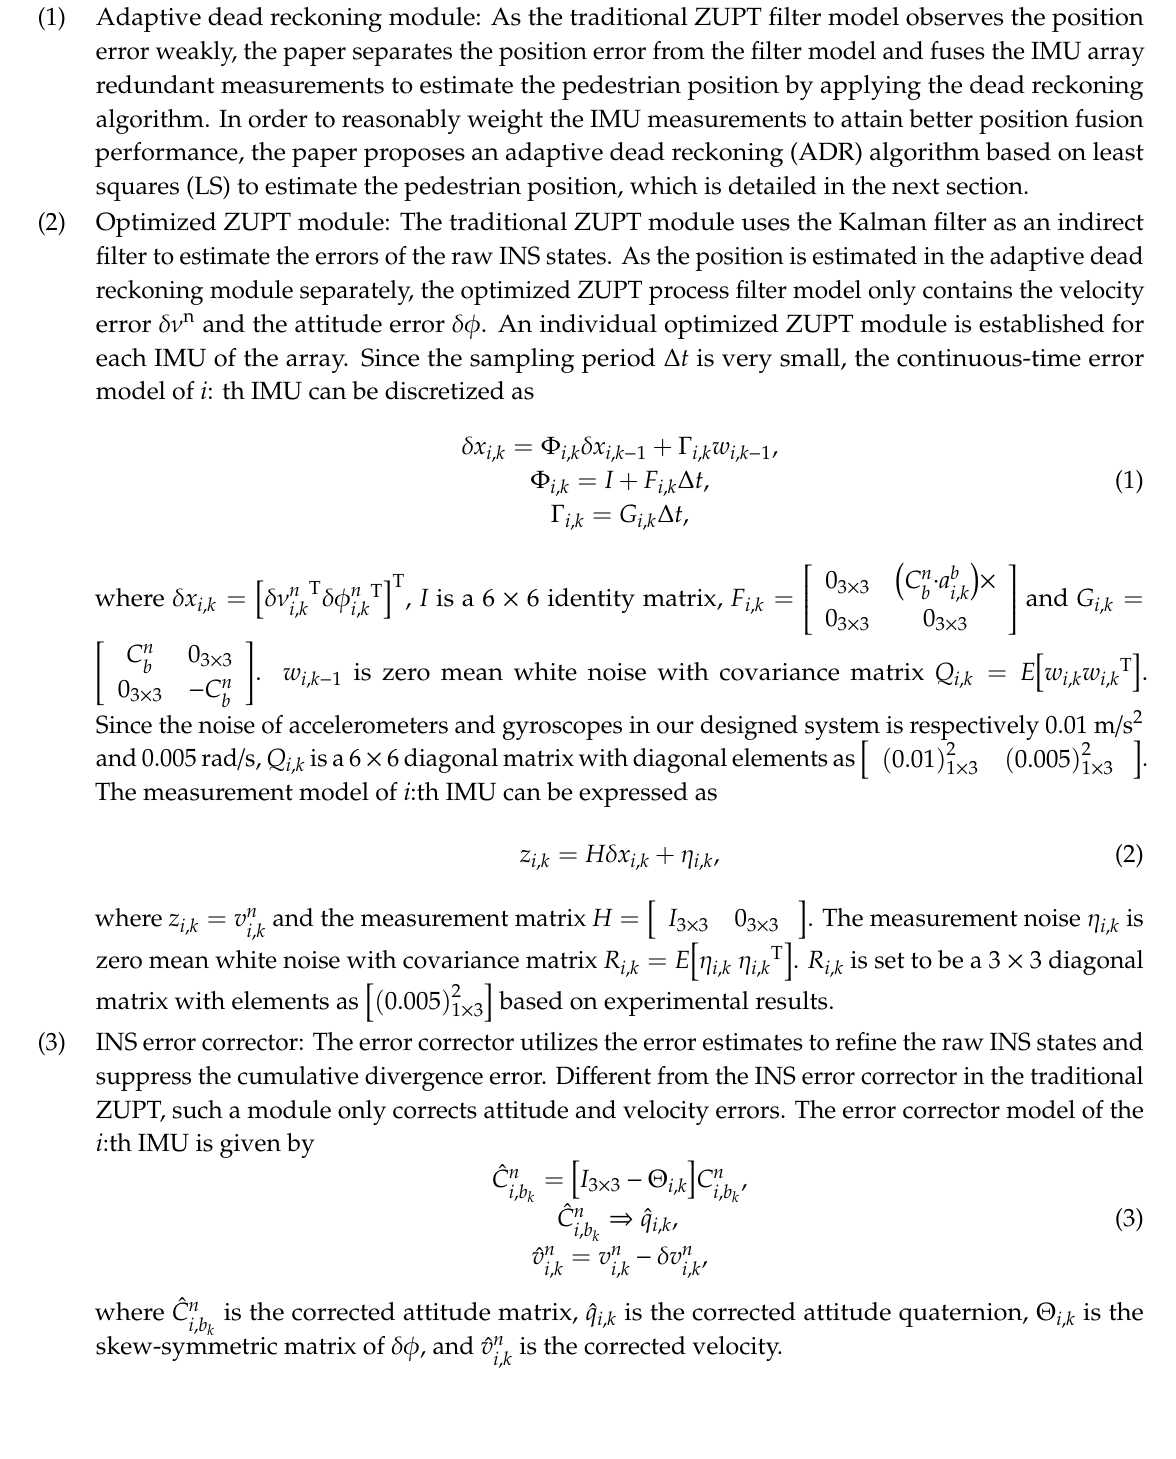
algorithm, the adaptive dead reckoning module is added in the proposed integrated structure. ZUPT filtering model and INS error corrector are optimized. The functionalities of these three modules are described